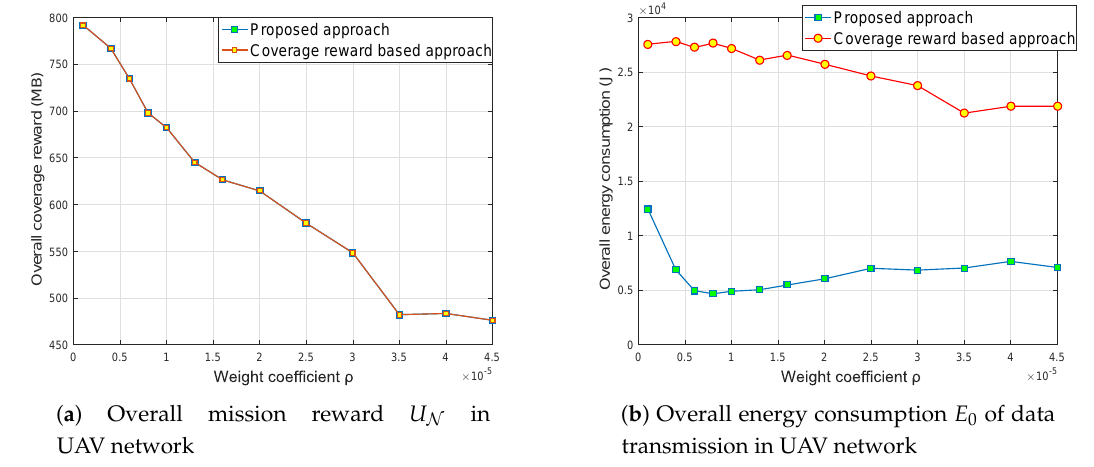
Figure 3. Performance comparison of algorithms based on weight coefficients (10